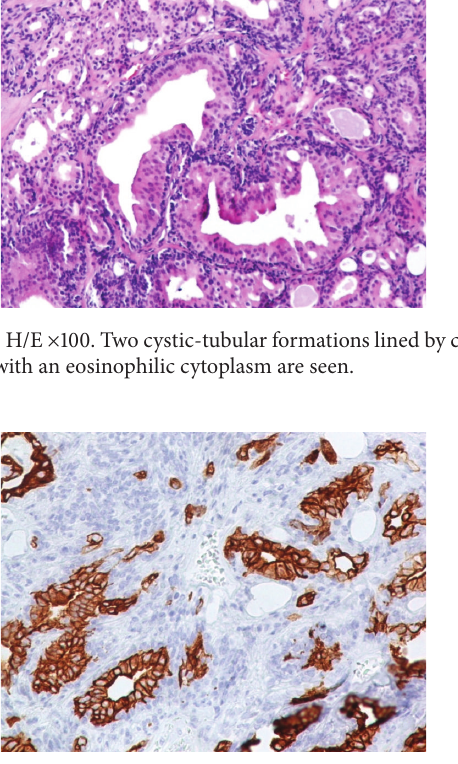
Figure 4: Immunostain for keratin 7 ( × 100): luminal cells are